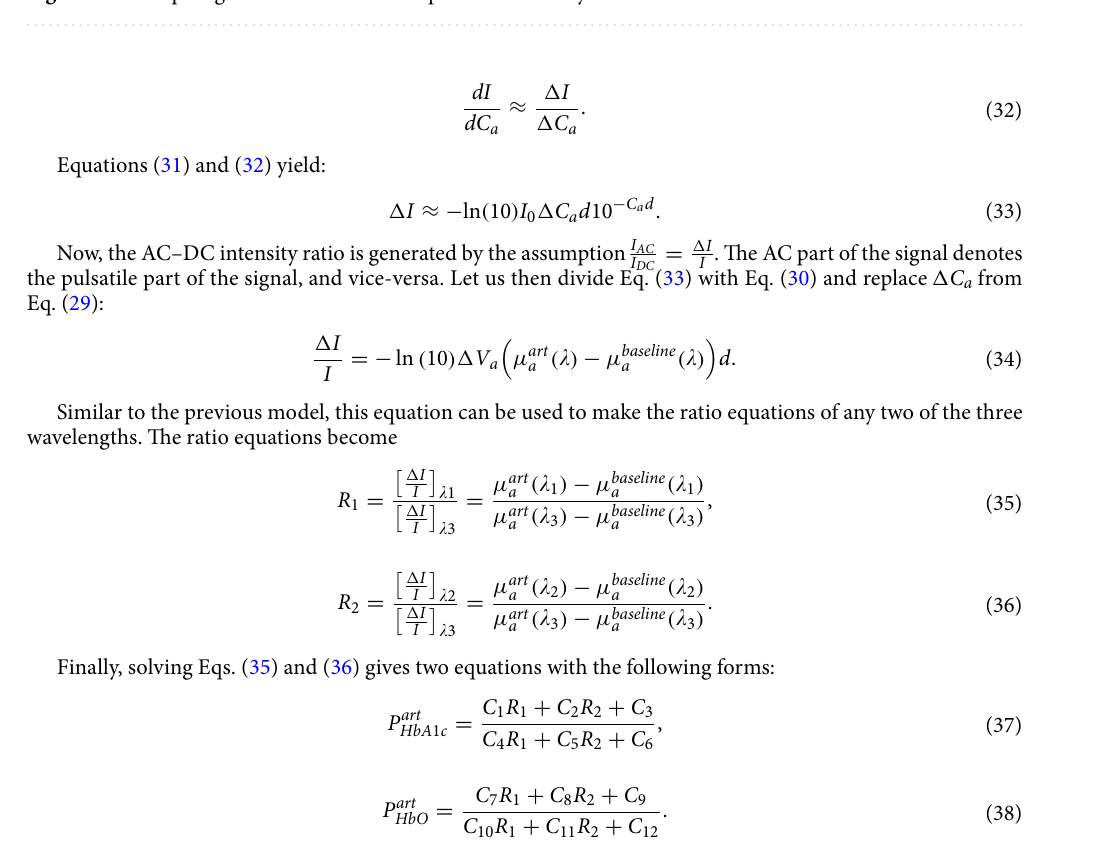
Figure 4. Multiple light sources versus multiple sensor filter